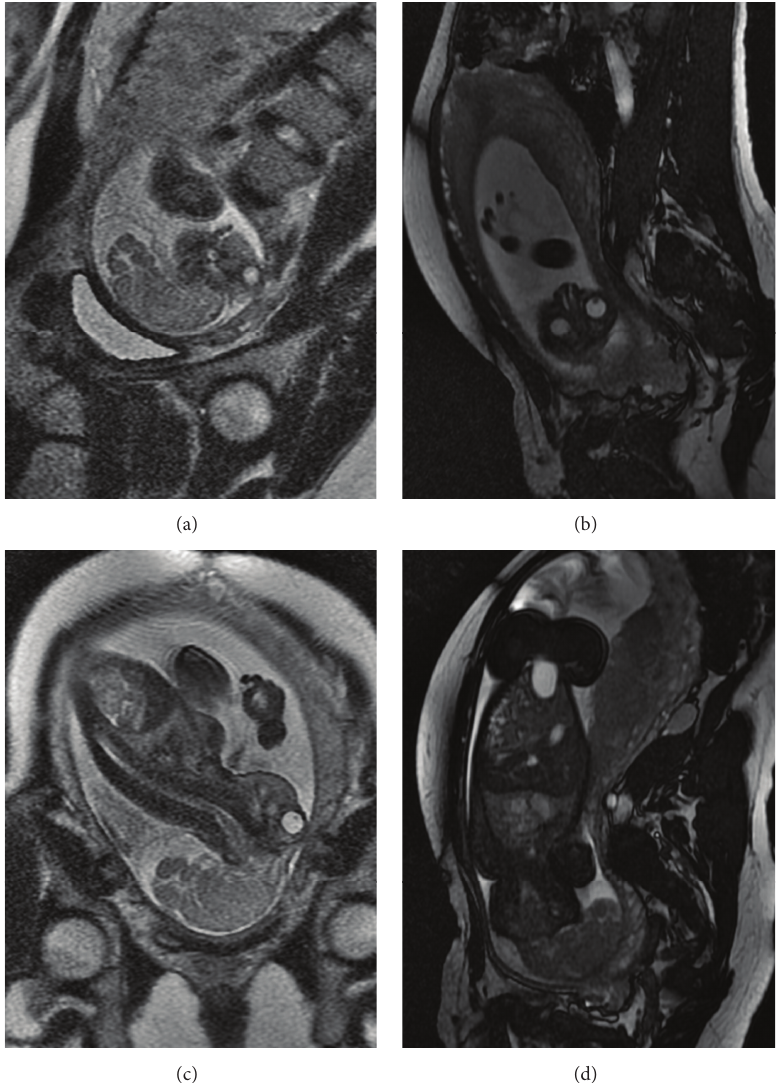
Figure 1: (a) Sagittal view fetal MRI demonstrating the absence of the calvarium with large mass of brain tissues hanging outside of the skull base and an incomplete layer of vascular epithelium covering the deformed brain. (b) Coronal view fetal MRI showing the intact skull base with normal appearing orbits and nasal cavity. (c) Sagittal view fetal MRI depicting the absence of the calvarium but intact orbits and skull base. The spine is normal without evidence of myelomeningocele. (d) Coronal view fetal MRI demonstrating exencephaly with grossly intact body